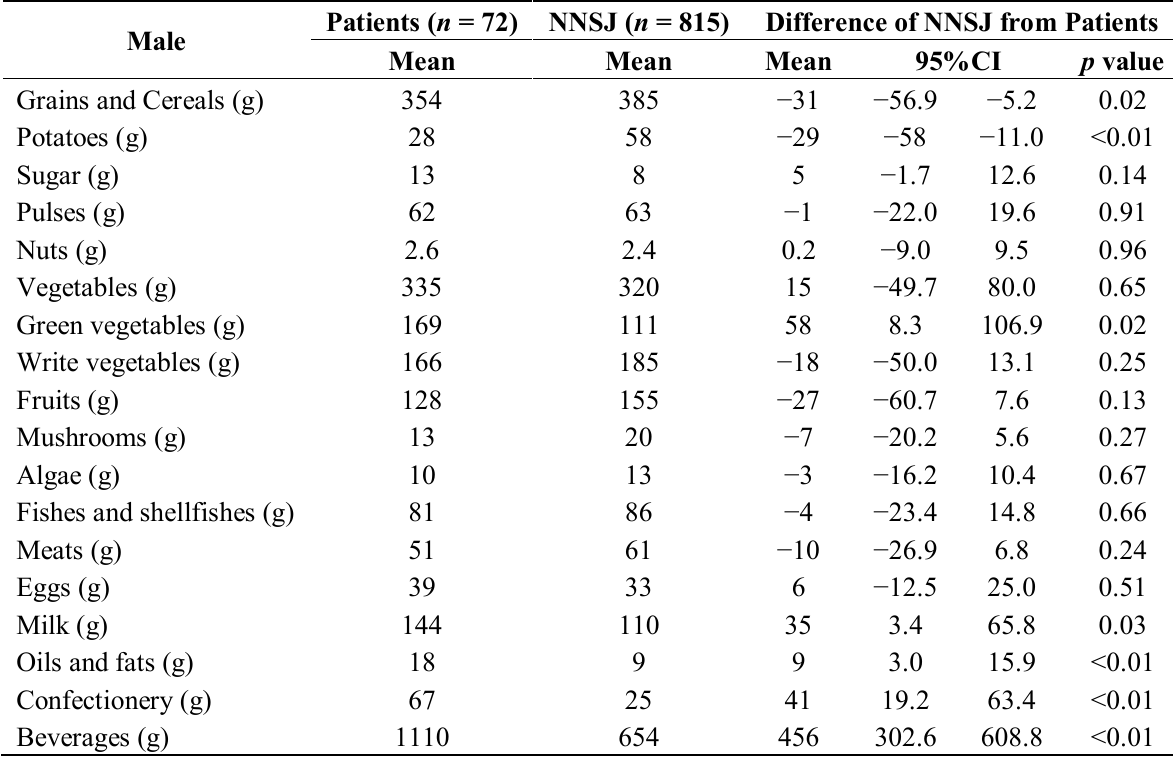
Table 3. The intake of food groups and nutrients in female patients, and comparison with the National Nutrition Survey of Japan (NNSJ) (per